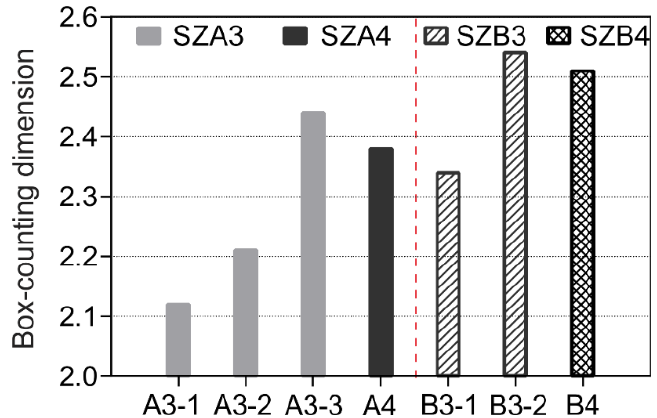
Figure 16. Crack BCD in different load stages of each specimen (A3-1: SZA3 at σ 1 = 79.58 MPa, A3-2: SZA3 at σ 1 = 103.45 MPa, A3-3: SZA3 at fractured; A4: SZA4 at fractured; B3-1: SZB3 at σ 1 = 103.45 MPa, B3-2: SZB3 at fractured; B4: SZB4 at fractured).